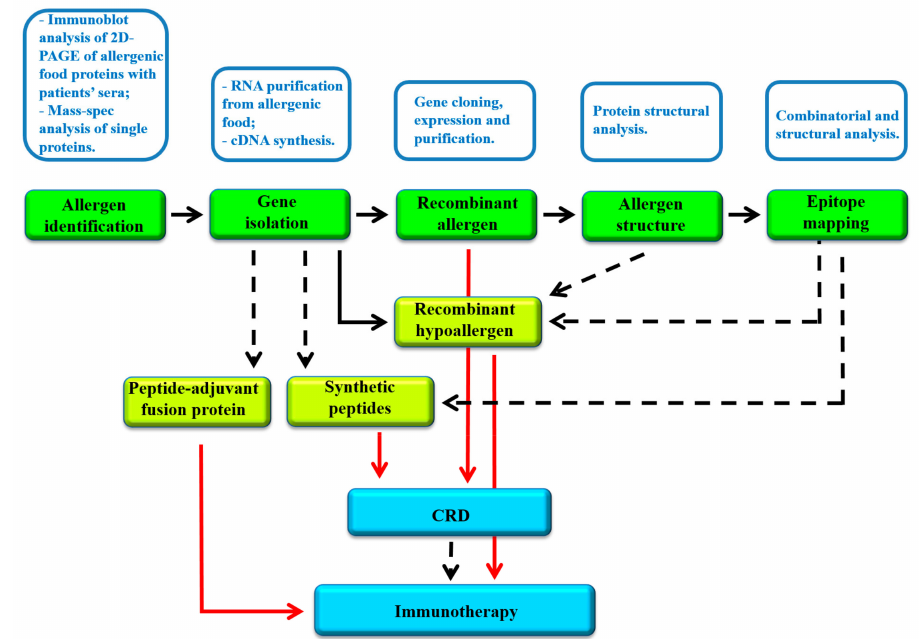
Figure 2. Scheme of a possible experimental workflow of molecular approaches for the identification of allergens from food sources, their characterization and development of diagnostic and therapeutic tools. Main procedures are reported in white boxes above the corresponding product, indicated in the green boxes. The results obtained can be then used for the development of molecular tools (yellow boxes) required for CRD and immunotherapy. Dashed arrows indicate the use of data. Red arrows indicate the application of the molecule to CRD or